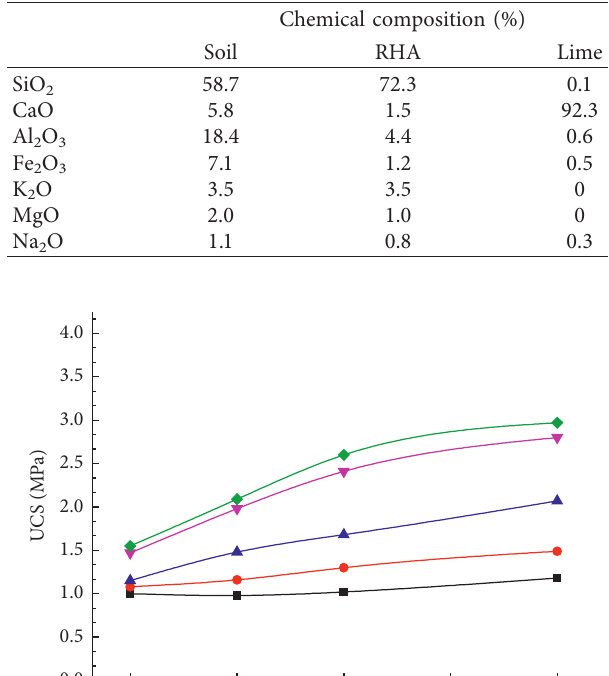
Table 1: Chemical compositions of raw